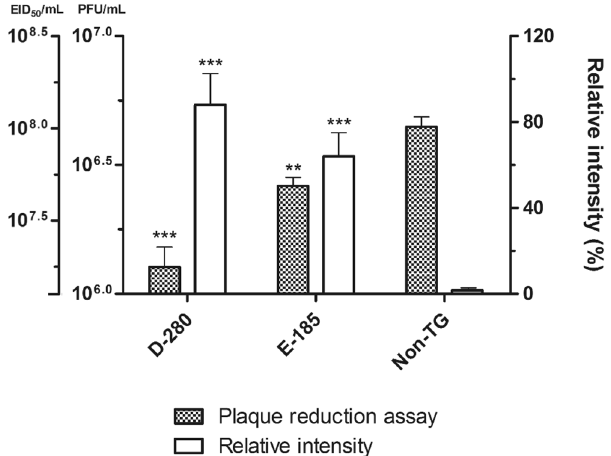
Figure 5. Plaque reduction assay from 3D8 scFv-expressing H9N2-infected CEFs with intensity of the Western blot bands. MDCK monolayers were infected with either undiluted or 10-fold diluted supernatant from 3D8 scFv-expressing H9N2-infected CEFs and overlaid with agar. After 48 hours, visible plaques were detected by crystal violet staining and then counted. The data are shown as the mean number of plaque-forming units for each assay in triplicate, and extrapolated 50% egg infectious dose were noted. Western blot band intensities of 3D8 scFv-expressing CEFs were quantified using Image J 1.31 V software. Statistical significance: ** p < 0.01; *** p < 0.001 by ANOVA with Tukey-Kramer post-test when compared with non-TG